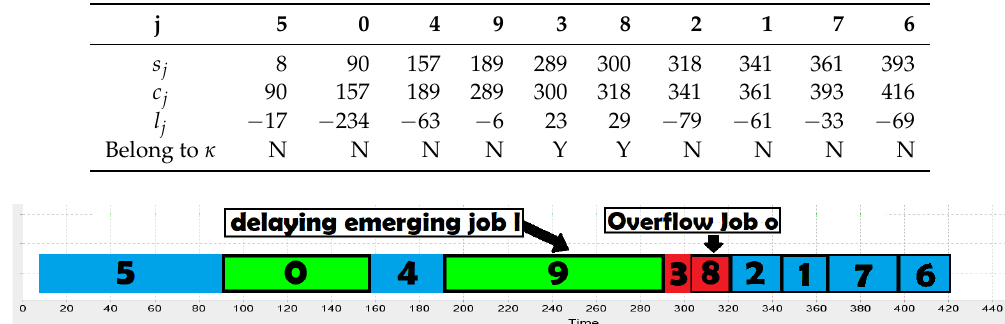
Table 2. Initial solution σ of the instance N_12_10.